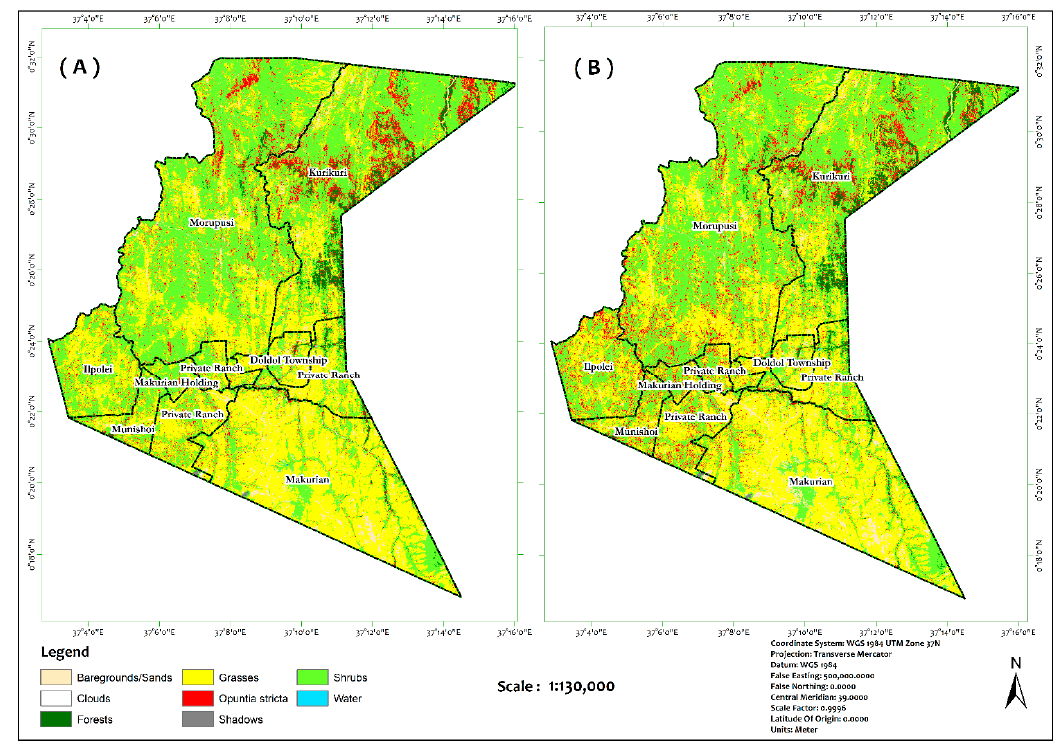
Figure 4. Maps showing the classification results of model 1.a and model 1.b (XGBoost and RF, respectively, with only the Sentinel reflectance bands as input), panel ( A , B ), respectively. The boundaries present the different land tenures present within the study area.